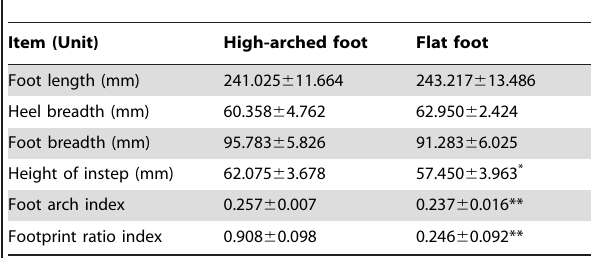
Table 1. Basic information of subjects’ feet.